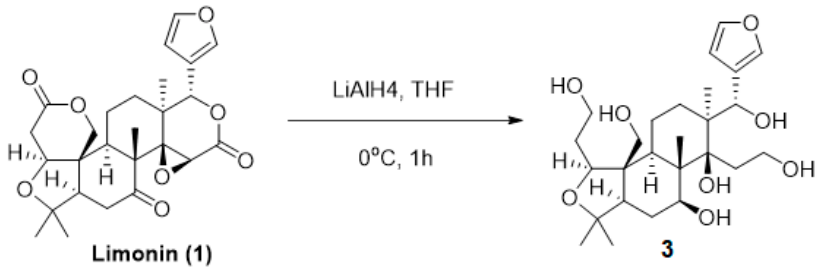
Figure 4. Hydrogenation of limonin by lithium aluminum hydride.